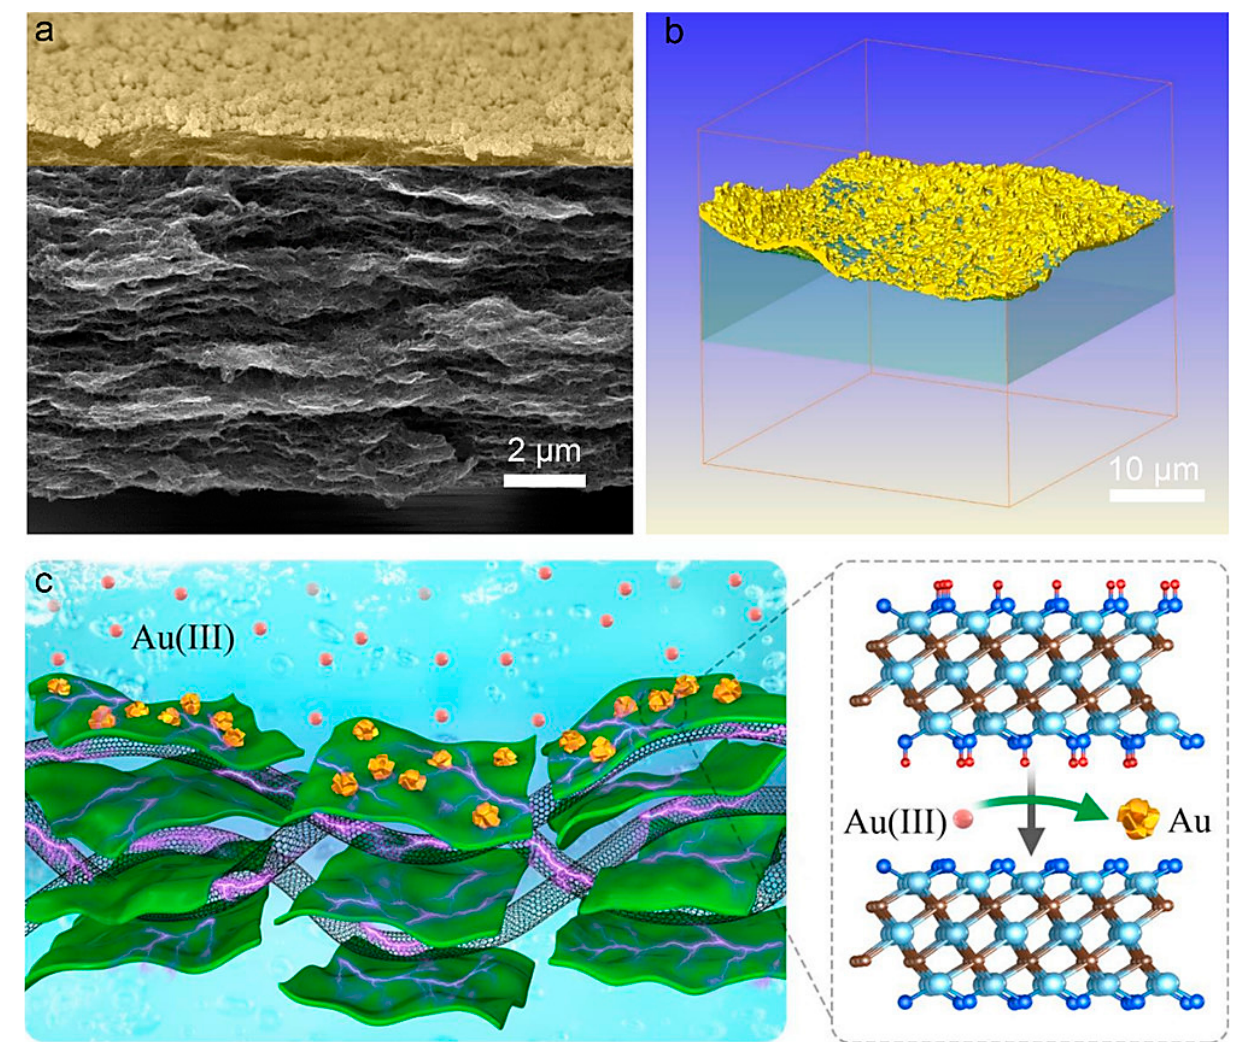
Figure 5. ( a ) SEM image of MXene/CNT-Au membrane (cross-sectional image). ( b ) Three-dimensional (3D) X-ray tomography (XRT) image of the membrane. ( c ) The proposed redox reaction mechanism of Au (III) rejection by the MXene-CNT hybrid membrane. Adapted from Ref [93] with permission. Copyright 2020 American Chemical Society.